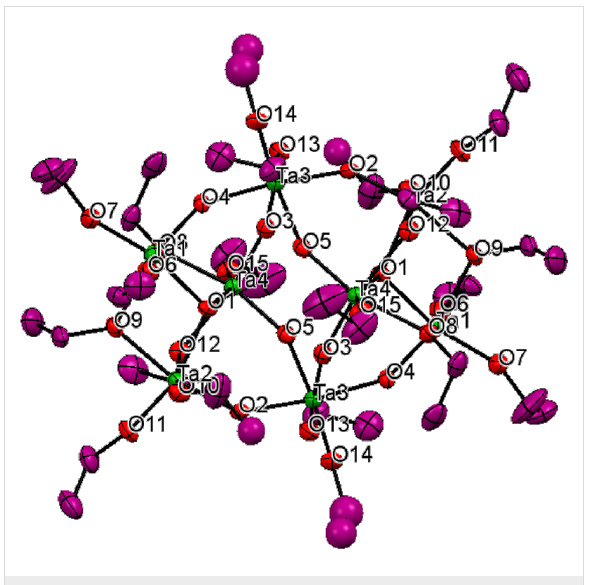
Figure 1: ORTEP representation of the molecular structure of 1 in the crystal (hydrogen atoms are omitted for